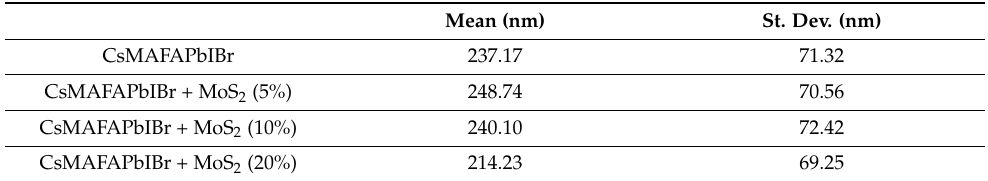
Table 3. Statistical analysis for the CsMAFAPbIBr grain size, with and without MoS 2